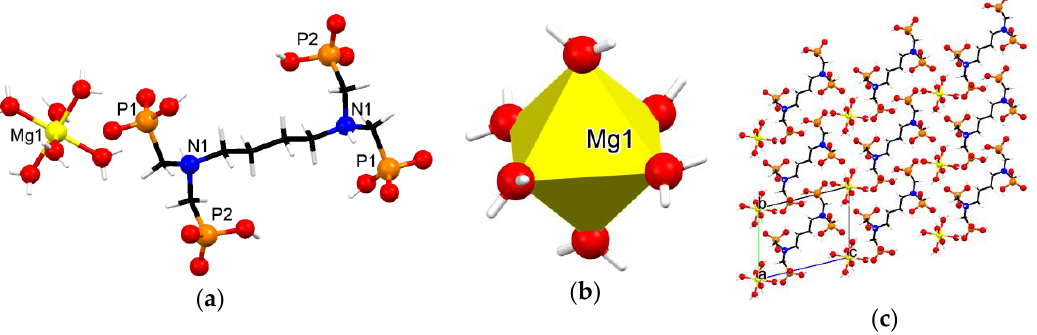
Figure 4. Crystal structure of Mg-DTTMP : ( a ) View of the cation-anion pair; ( b ) The [Mg (H 2 O) 6 ] 2+ polyhedron; ( c ) Packing along the a axis.